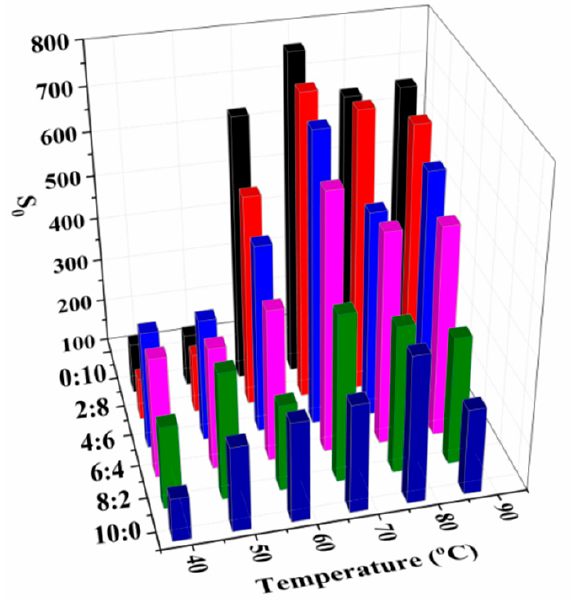
Figure 7. Hydrophobicity (S 0 ) of the SP and MP system with various SP/MP proportions at different temperatures.